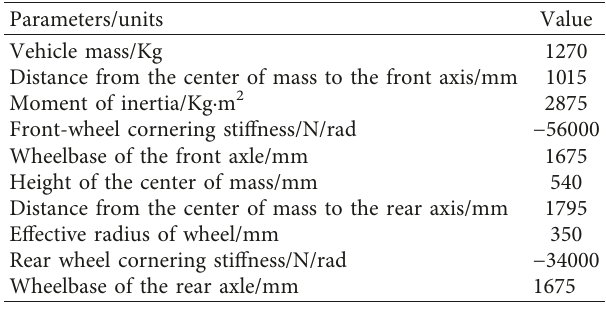
Figure 15: Tracking control strategy. Table 2: Vehicle parameter